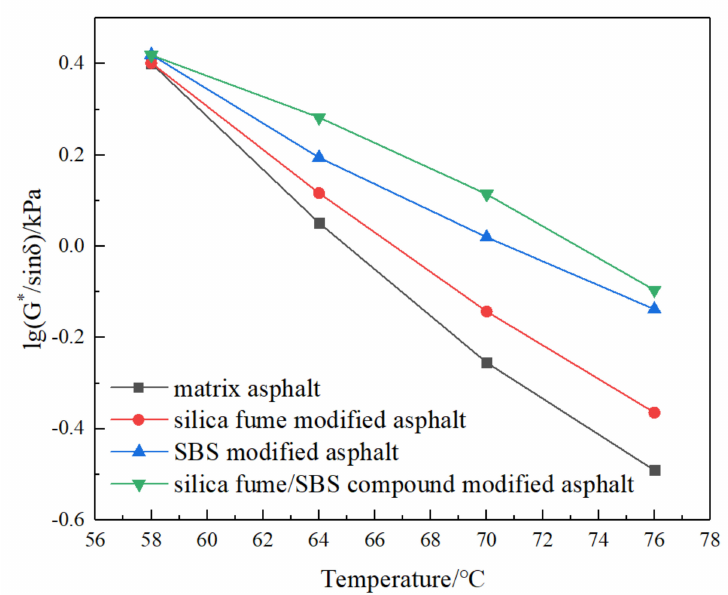
Figure 5. LG (G * / sin δ )—T curve of four kinds of asphalt.